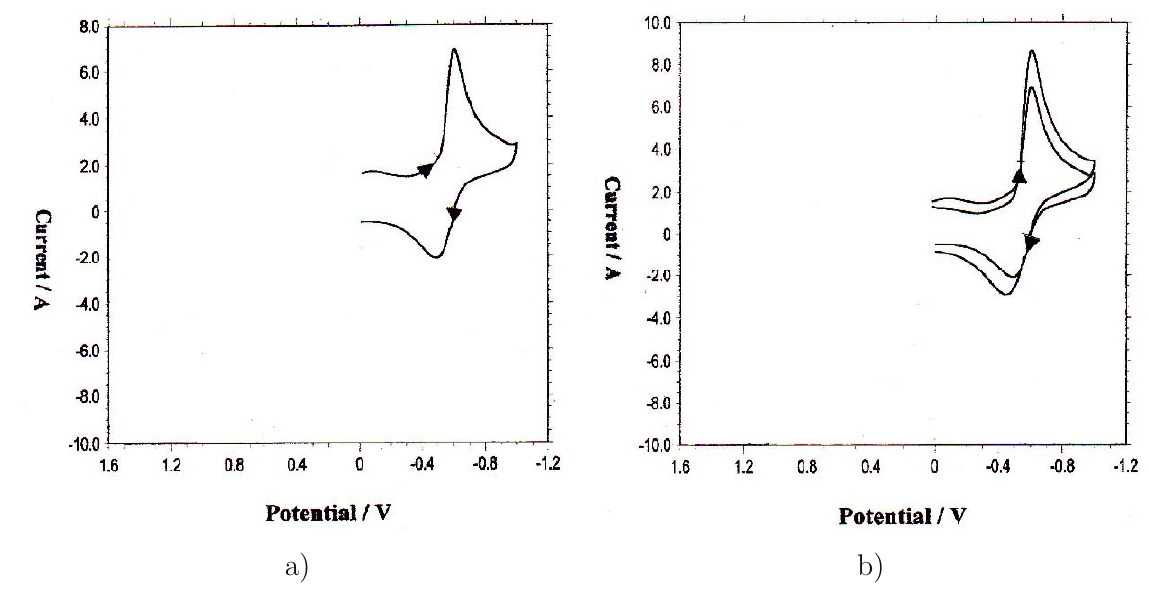
Fig. 1 Cyclic voltammogram (scan rate 0.2 Vs − 1 , DMSO, 25 ◦ , pH 7.5) of (a) complex 1 alone and (b) complex 1 in presence of CT-DNA. [Complex 1 ] 1 × 10 − 3 M, [DNA] 6 × 10 − 3